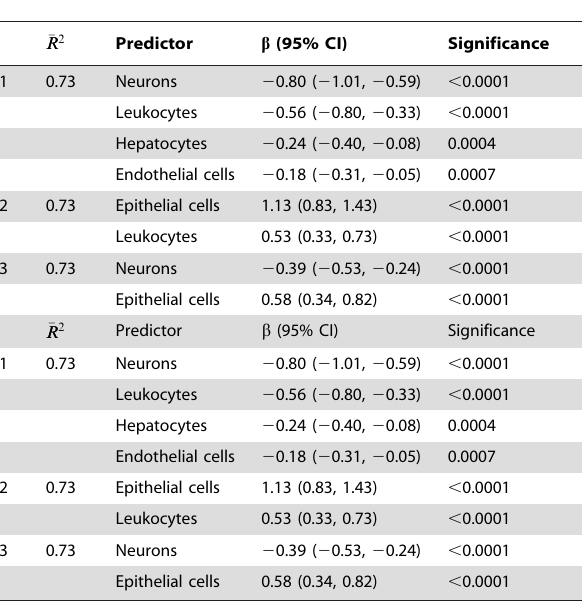
Table 1. Significant predictors of viral structural gene substitution rates.